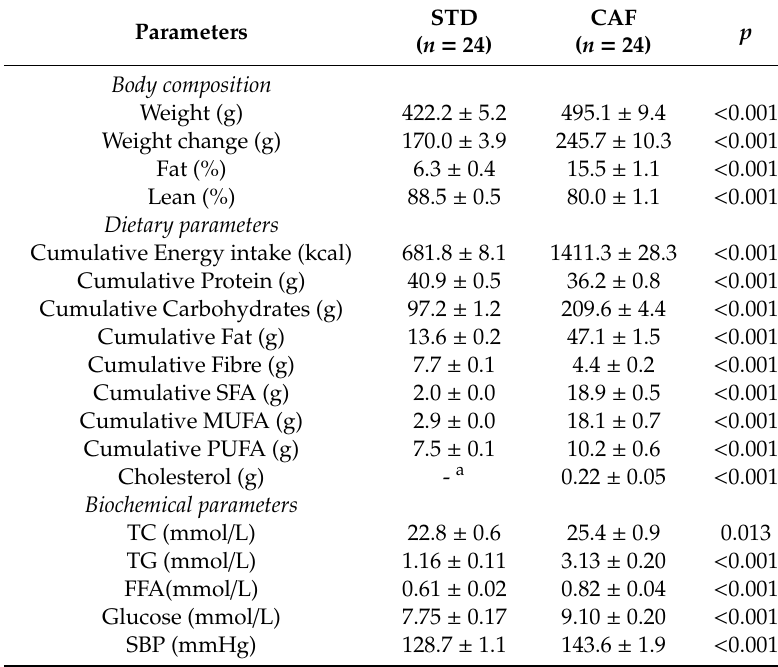
Table 1. Body composition and dietary and biochemical parameters of rats fed with a standard (STD) or a cafeteria (CAF) diet at the 10th week of the